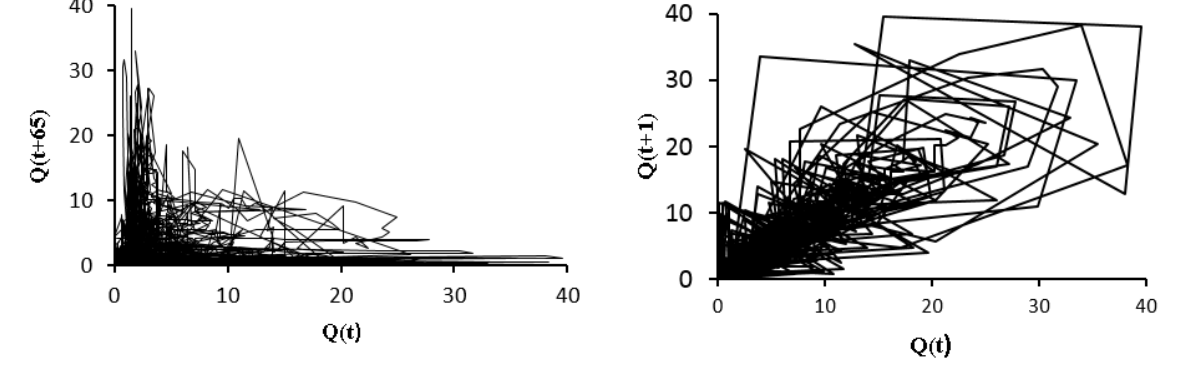
Fig. 6 Reconstruction of Phase Space for Time Series at Orang Station